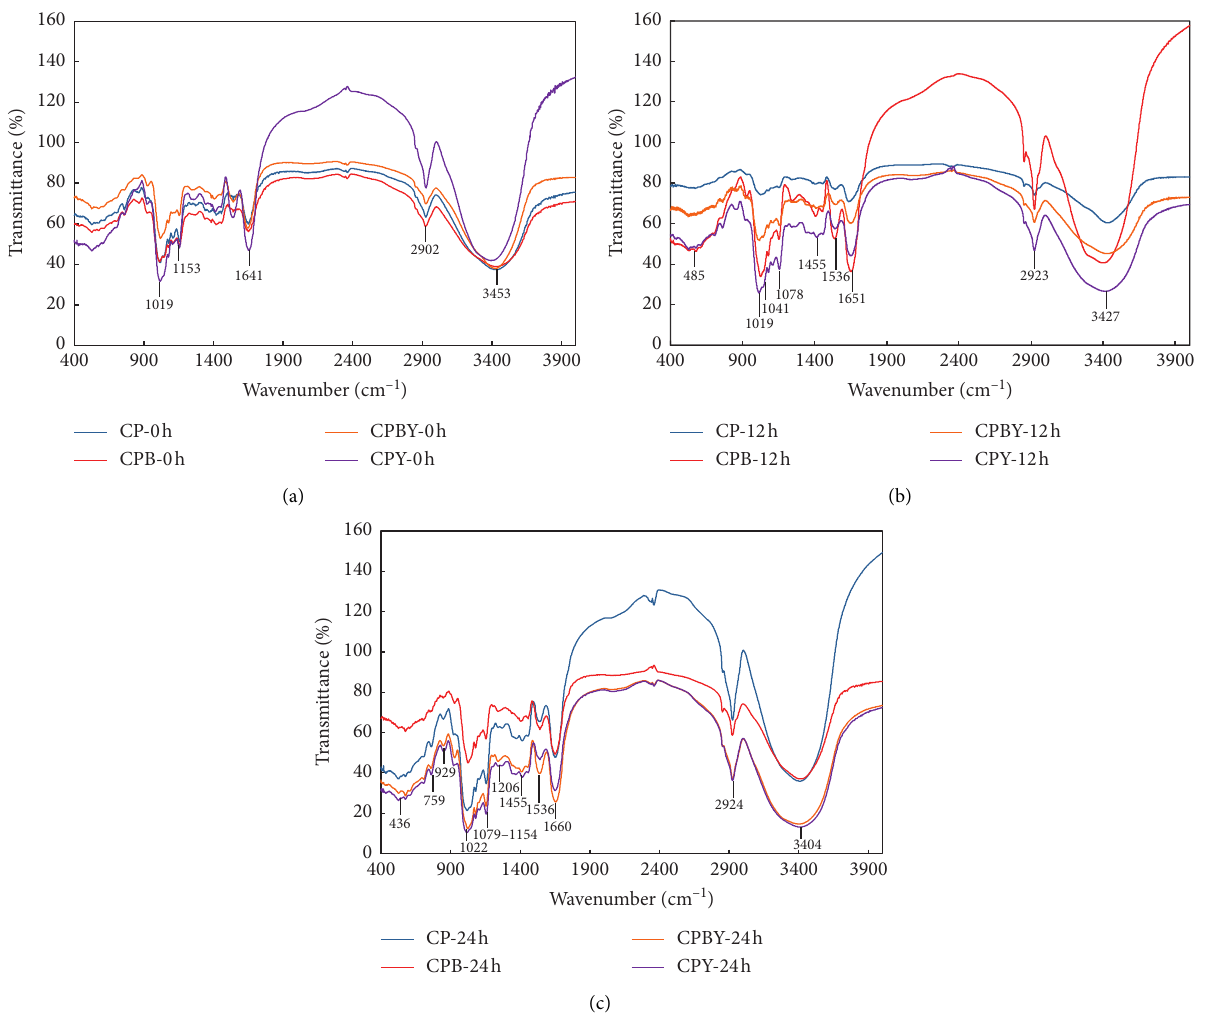
Figure 2: FTIR spectrum analysis of polysaccharides of four samples at 0h (a), 12h (b), and 24h (c). CP, chickpea fermentation milk; CPB, chickpea fermentation milk with enzyme hydrolysis; CPY, chickpea yam fermentation milk; CPBY, chickpea yam fermentation milk with enzyme hydrolysis.